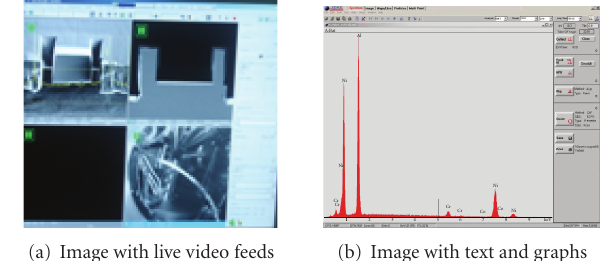
Figure 2: Comparison of video activity levels in instrument image